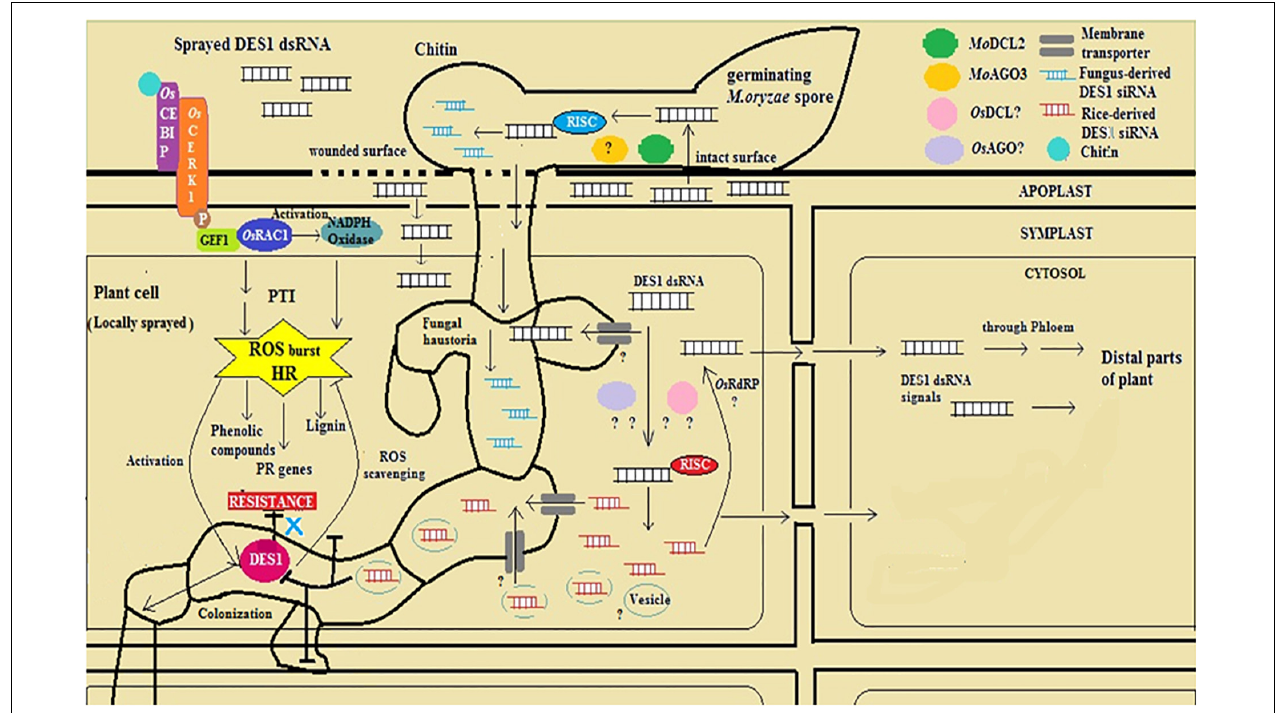
FIGURE 9 | Diagrammatic representation of mode-of-action of ds DES1 in conferring spray-induced gene silencing (SIGS)-mediated fungal blast resistance in rice.